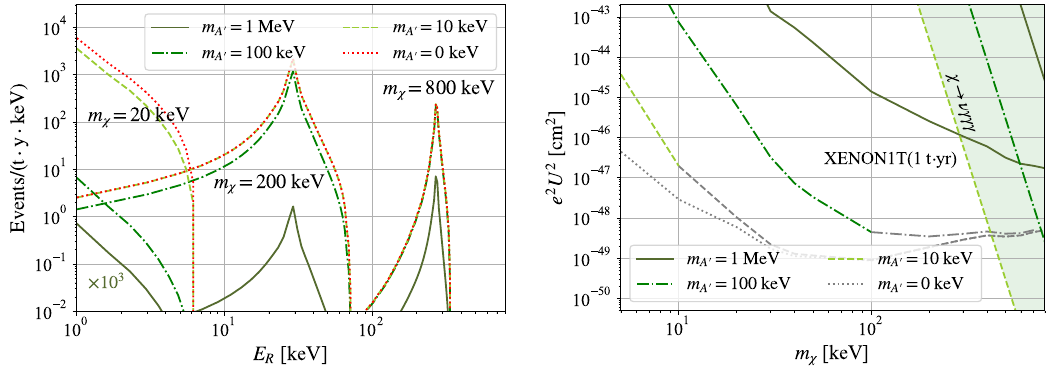
Figure 7 . Left: ionization rate with different masses of DM and dark photon m A 0 . The coupling e 2 U 2 is fixed at 10 − 45 cm 2 . The curve corresponding to m χ = 20 keV and m A 0 = 1 MeV has been multiplied by a factor of 10 3 . Right: the projected constraint on e 2 U 2 from the electron ionization of 131 Xe with an exposure of one tonne · year. The shaded region has been ruled out by DM lifetime.